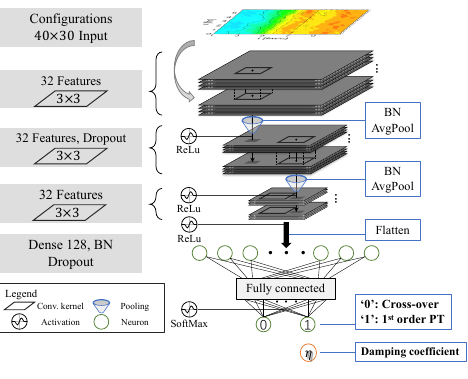
Figure 1. The architecture of the deep CNNs for recognizing the phase order and predicting the damp- ing coe ffi cient from the σ field configurations. Details of the network structure can be found in Ref.